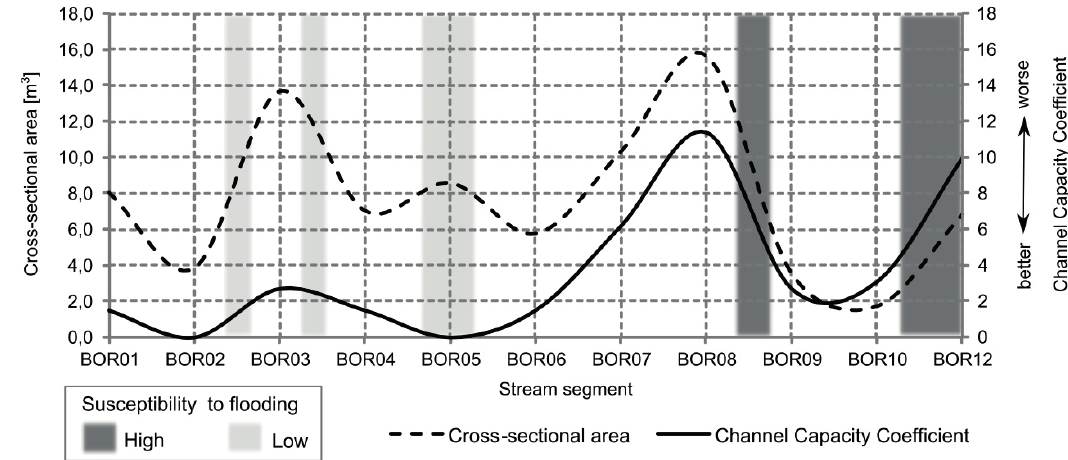
Fig. 3 Possible way to identify the risk locations within a small stream